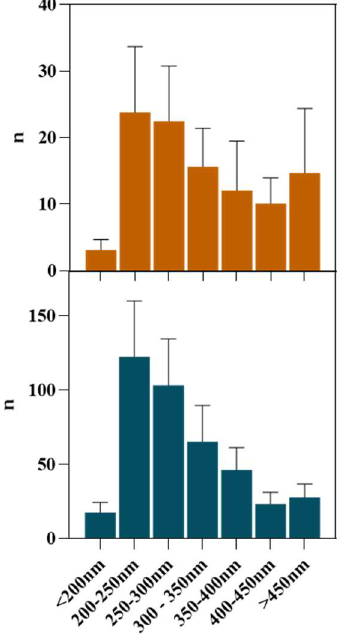
Figure 15. Size distribution of Lys-Rho in the presence of 1.2 and 10% v / v [C 2 C 1 Im][C 4 F 9 SO 3 ].